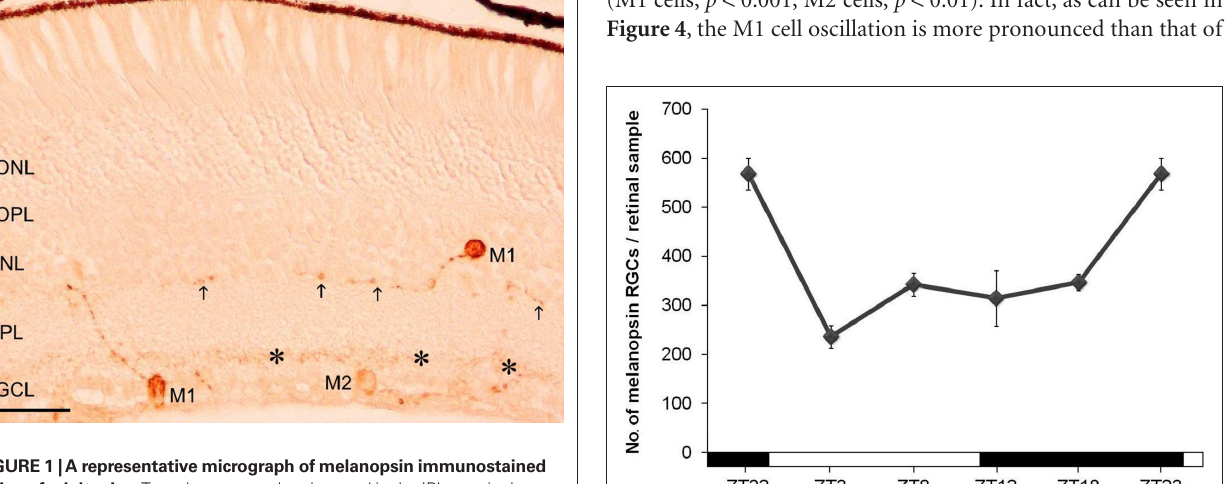
FIGURE 1 | A representative micrograph of melanopsin immunostained retina of adult mice. Two plexuses can be observed in the IPL, one in the innermost layer (OFF sublayer, asterisks) and the other in the outermost layer (ON sublayer, arrows). Three immunostained cells can be seen: two M1 cells (with dendritic arborization in the OFF sublayer) and one M2 cell (with dendritic arborization in the ON sublayer). GCL, ganglion cell layer; IPL, inner plexiform layer; INL, inner nuclear layer; OPL, outer plexiform layer; ONL, outer nuclear layer. Scale bar: 50 µm.